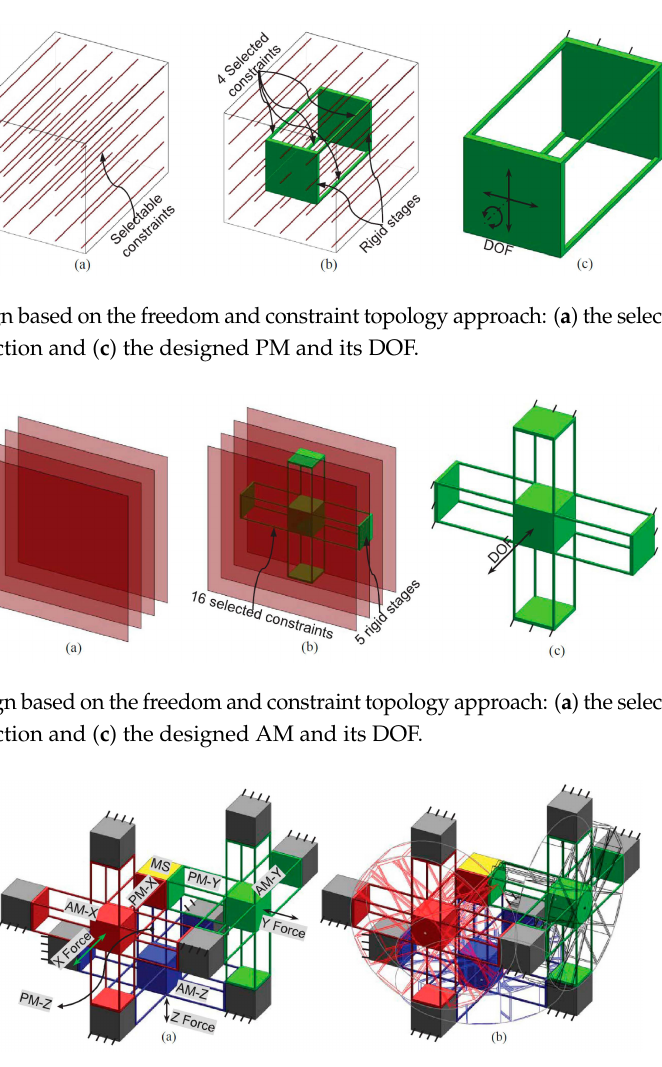
Figure 4. Assembly of the rigid stages and the compliant modules: ( a ) three-legged XYZ CPM assembled, based on the coordinate systems shown in Figure 1 and ( b ) illustration of some permitted positions of the PMs and AMs.